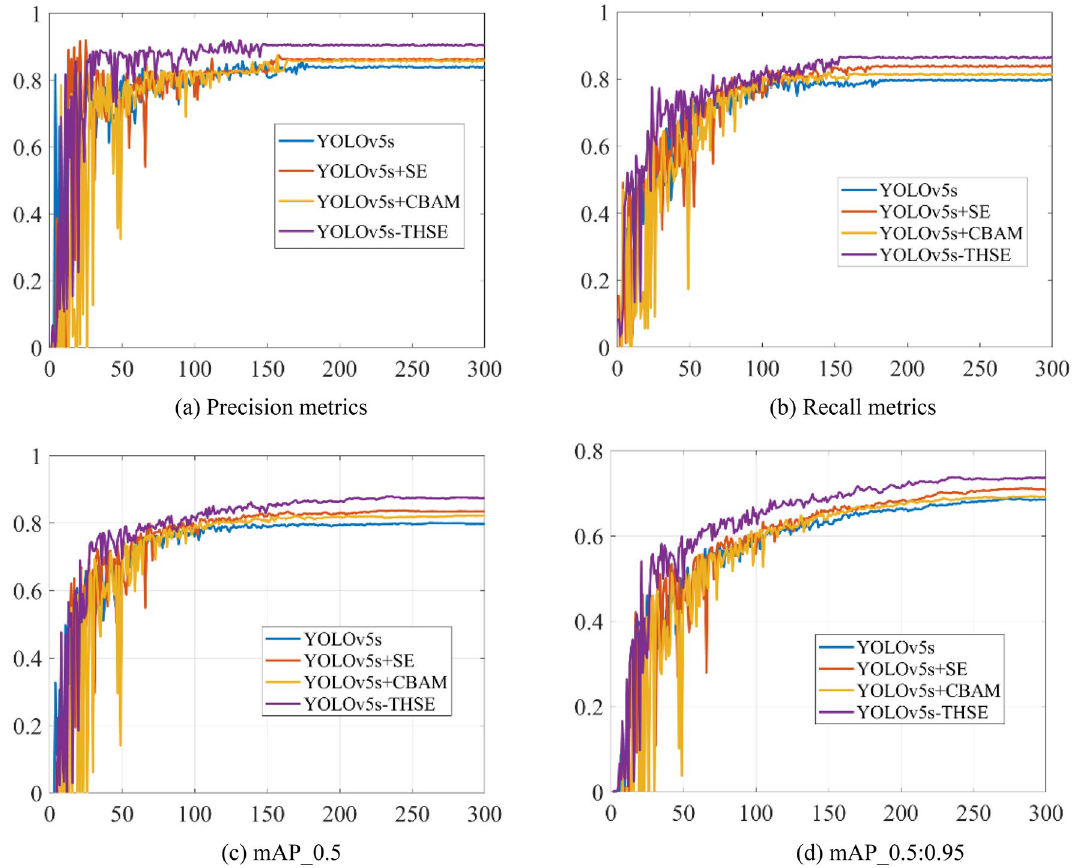
Figure 11. Comparison of indicators on small target data sets. ( a ) Precision metrics, ( b ) Recall metrics, ( c ) mAP_0.5, ( d )